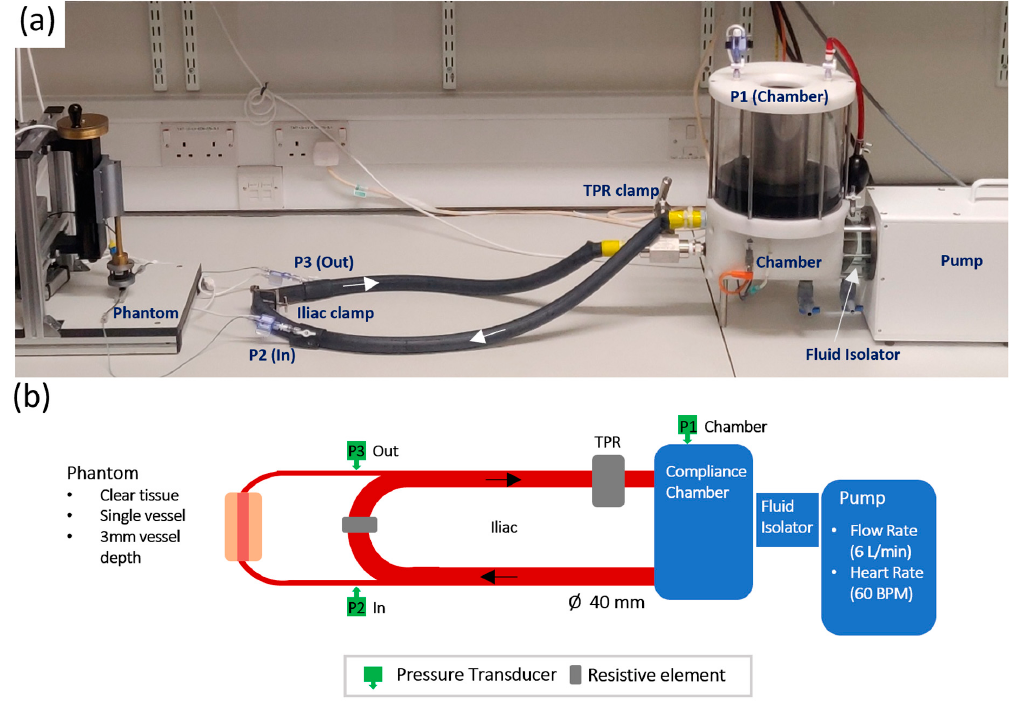
Figure 4. Pump setup. Actual in-vitro lab setup ( a ), with diagrammatic representation of all major components ( b